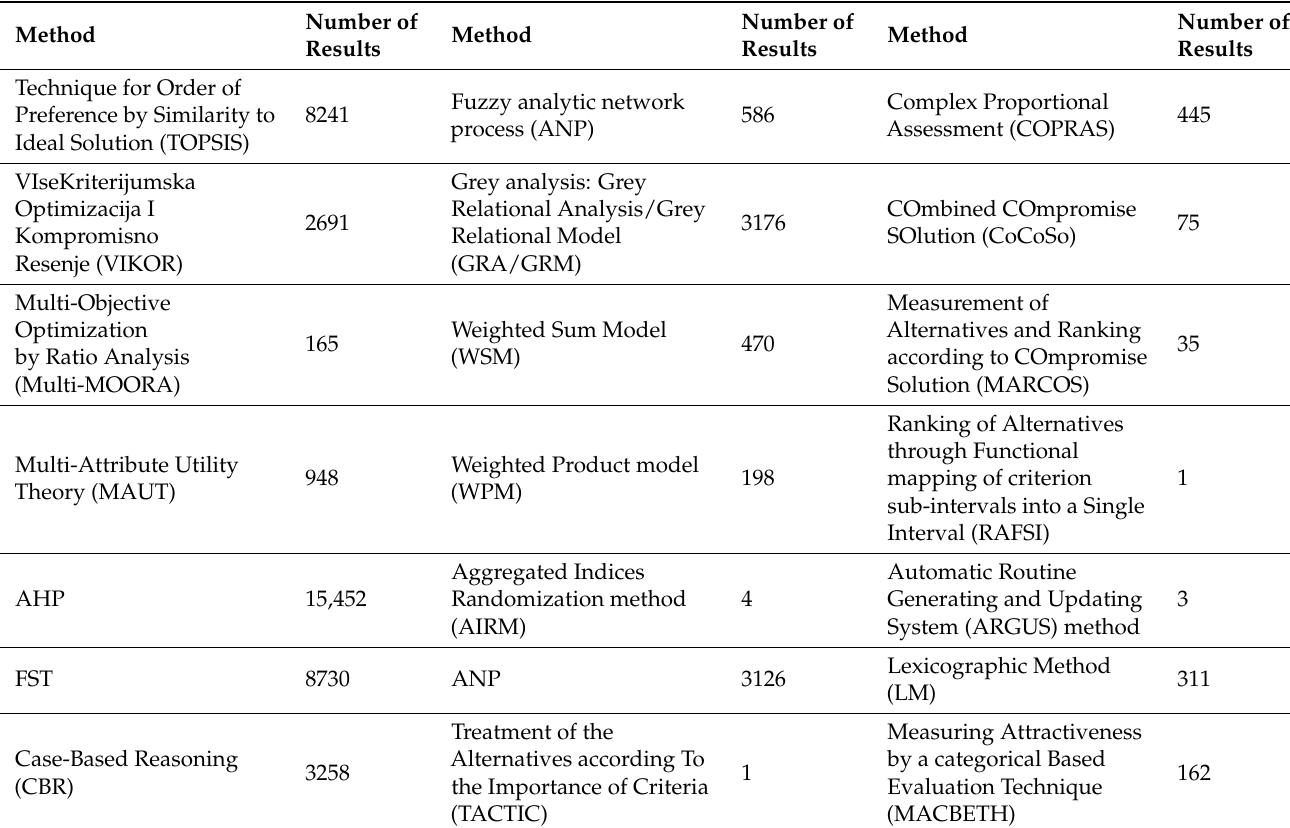
Figure 5. Subject Areas in MCDM Studies—Number of Articles based on Subject Area. Table 3. List of MCDM